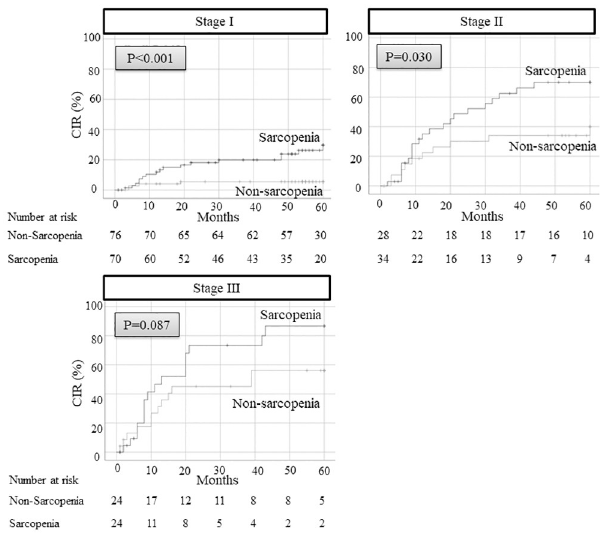
Fig 3. CIR rate after surgery between sarcopenia patients and non-sarcopenia patients divided according to their pathological stages. CIR, cumulative incidence of recurrence.